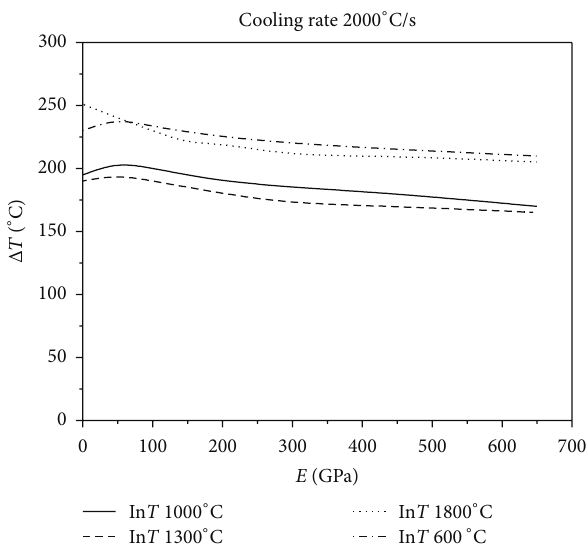
Figure 7: Relationship between critical fracturetemperatures corre- sponding to different thermal shock initial temperature and Young’s modulus of constraint material under the cooling rate 100 ∘ C/s.